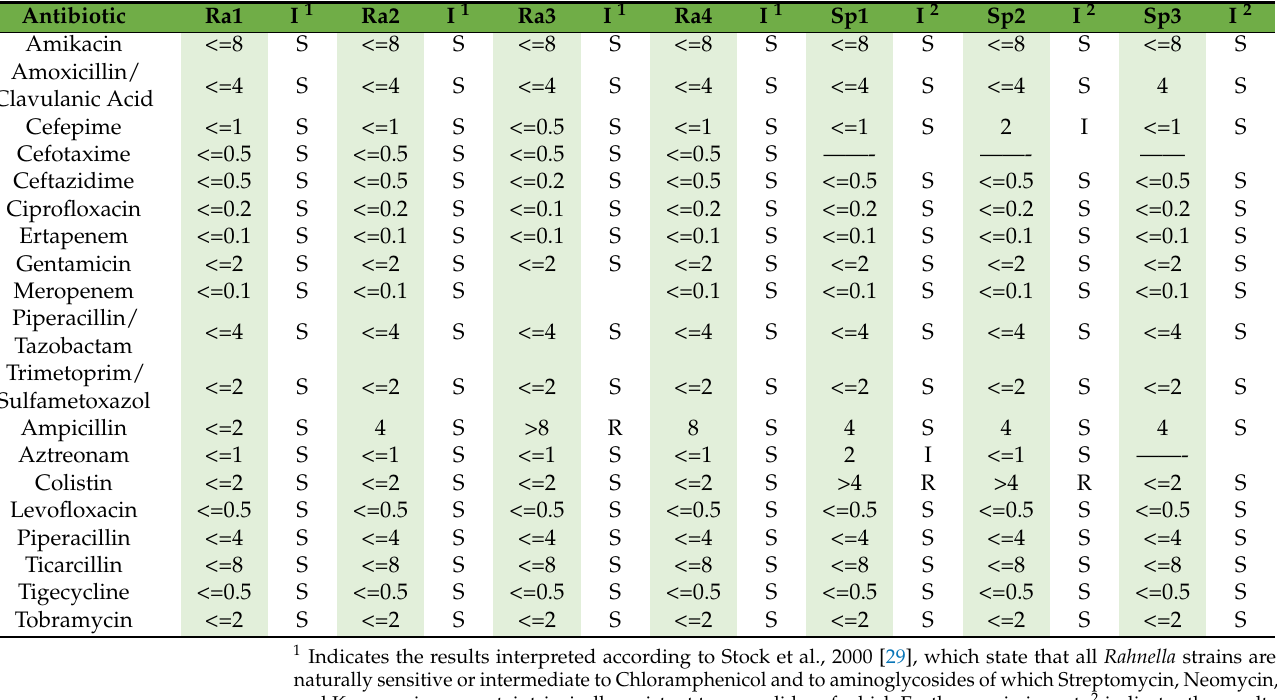
Table 5. Antibiotic response of the different strains, isolated from fava bean and pea nodules, determined using Vitek2. The results were interpreted according to EUCAST Clinical Breakpoint Tables v. 12.0.